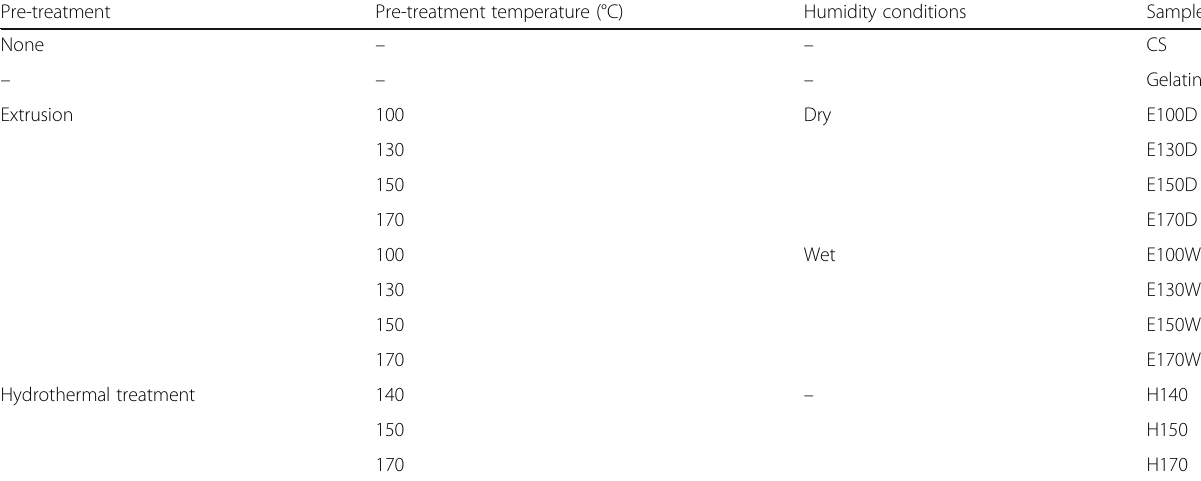
Table 1 Pre-treatment conditions and sample nomenclature